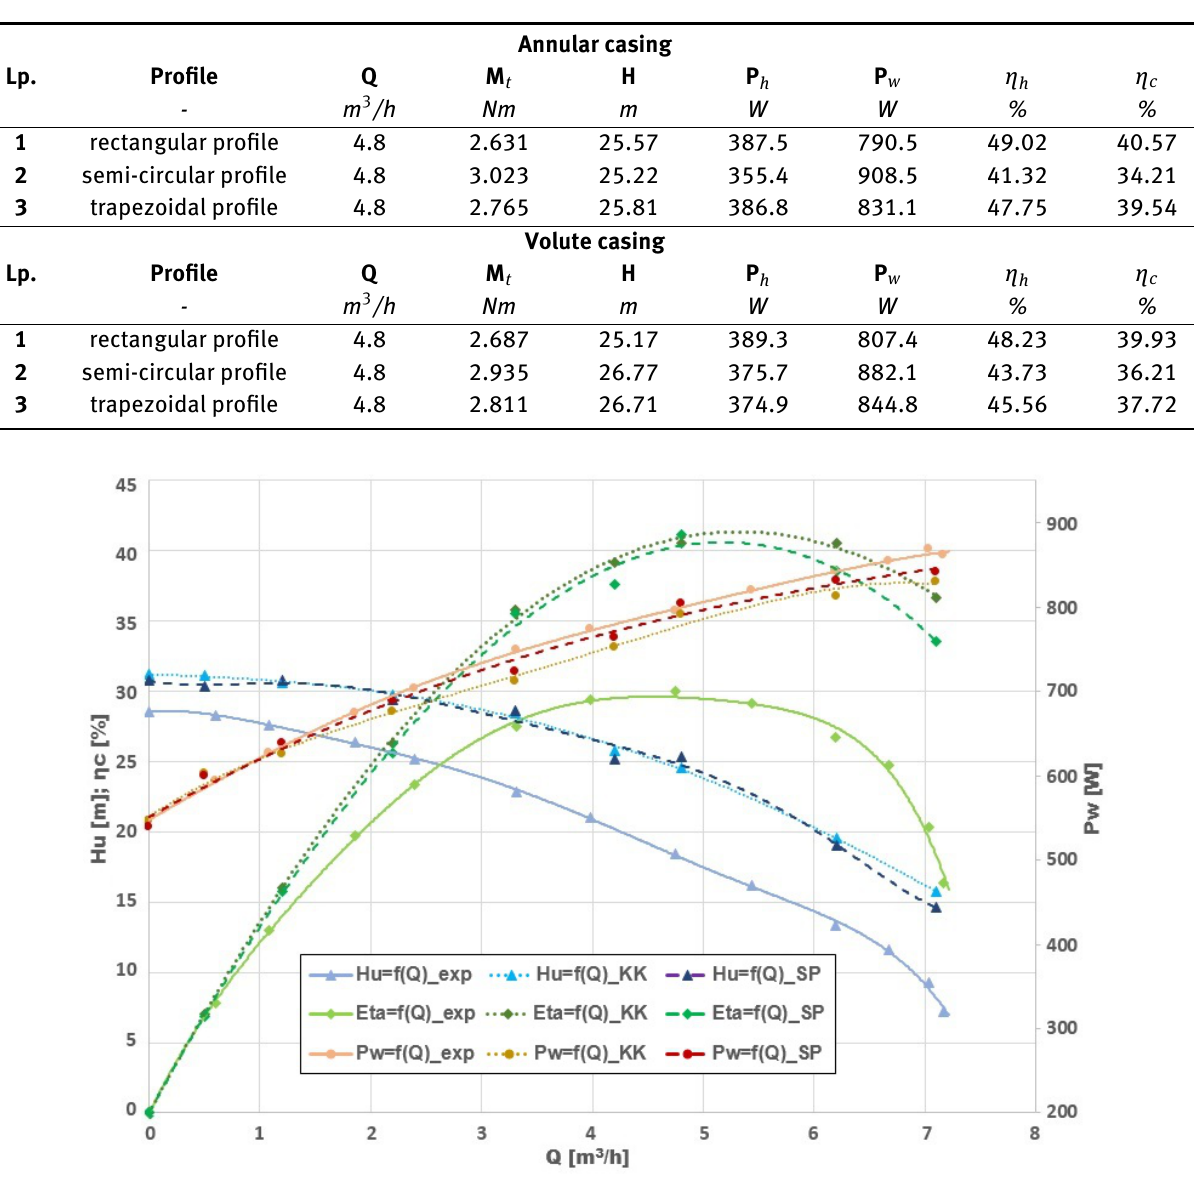
Table 3: Influence of changes in the shape of the cross-sectional profile in both types of stators.